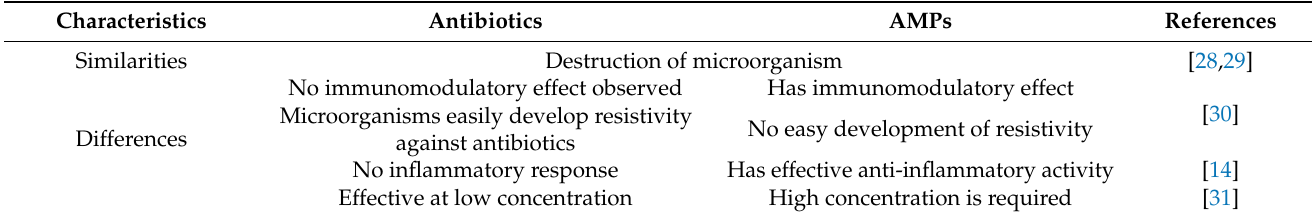
Table 1. Comparative study between antibiotics and